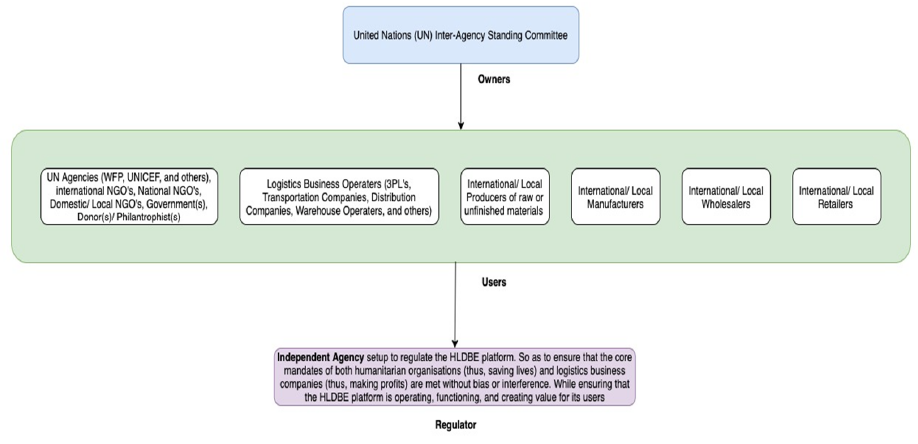
Fig. 2. HLDBE Architecture, Sources: Authors, Created by Draw.io